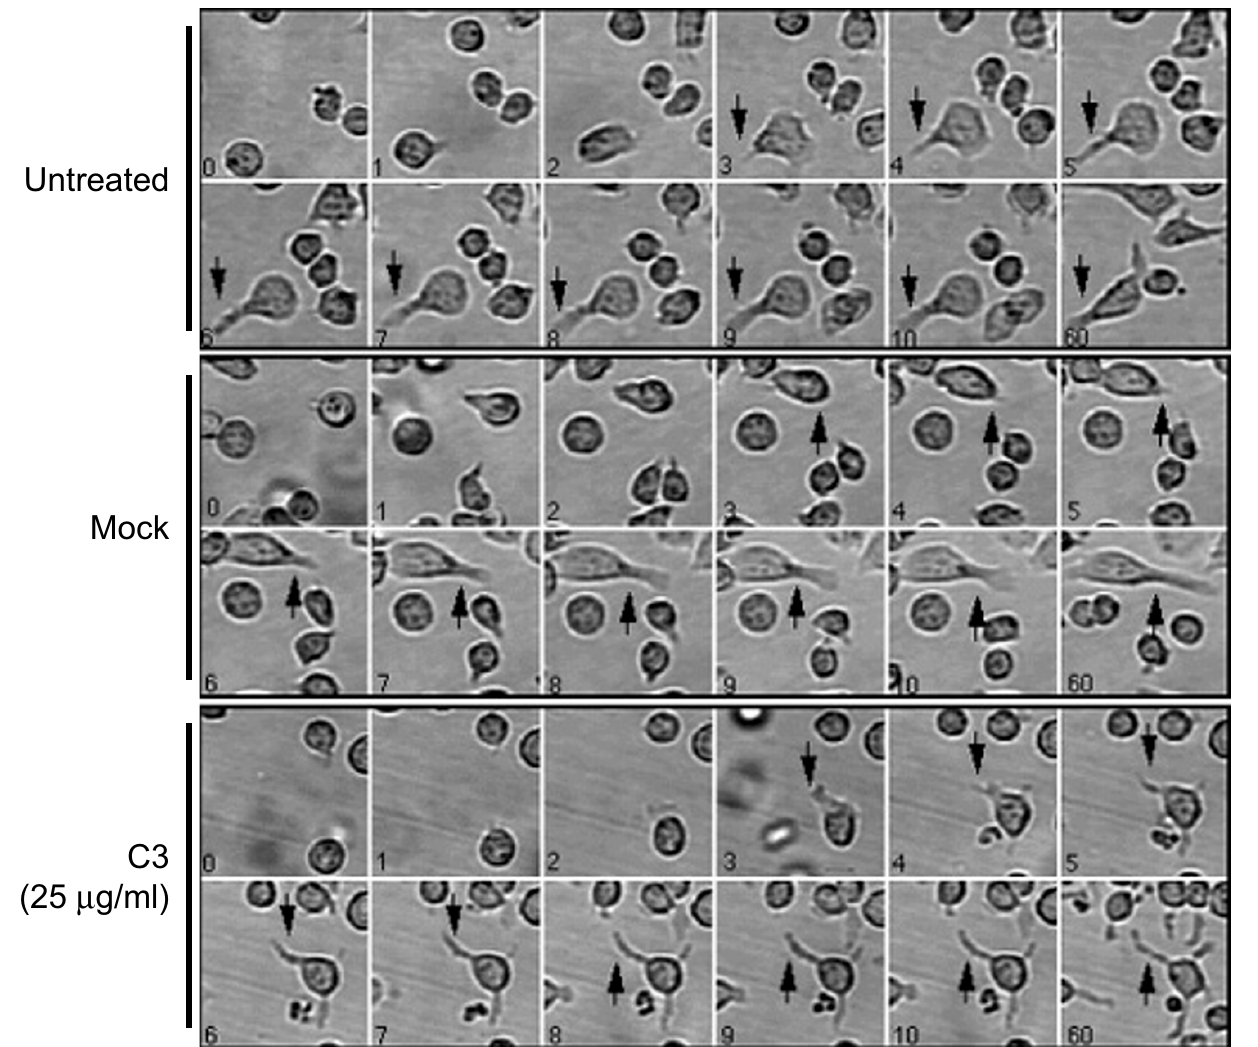
Video time lapse microscopy demonstrates that the morphologically distinct HPB-ALL pseudopodia are due to aberrant exten- sion, rather than aberrant pseudopodial retraction. Cells were "untreated," subjected to electroporation in control buffer ("mock electroporated"), or electroporated in the presence of C3 (25 µ g/ml, "C3 electroporated"). Cells were then plated onto VCAM-1 and let spread for 1 hr (as described in Materials and Methods ) while being recorded by a CCD camera and time lapse VCR. Numbers in lower left corners of images denote time elapsed in minutes. Arrowheads identify pseudopodia of spreading cells. Initial magnification was